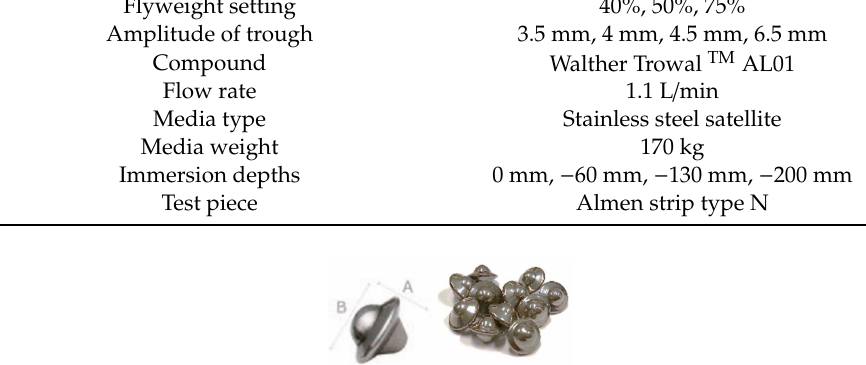
Figure 2. Satellite 5 / 7mm stainless steel media.